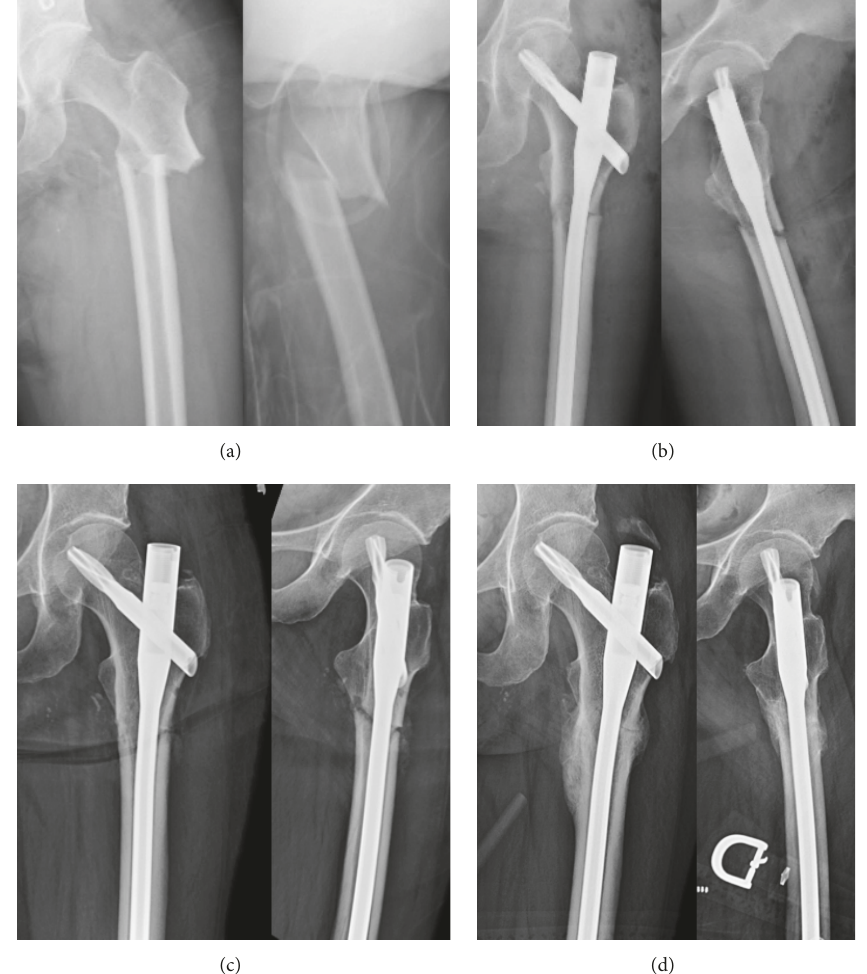
Figure 3: (a) Atypical left femur fracture sustained after a fall from standing in a 58-year-old female with history of bisphosphonate use. (b) She underwent closed reduction and cephalomedullary nailing with a slightly medial start point to induce slight valgus alignment with the trochanteric proximal nail bend. (c) At 6 weeks postoperatively, she denies pain and is ambulating without assistance. Fracture alignment is maintained. (d) At 6 months, she has radiographic union and is back to all